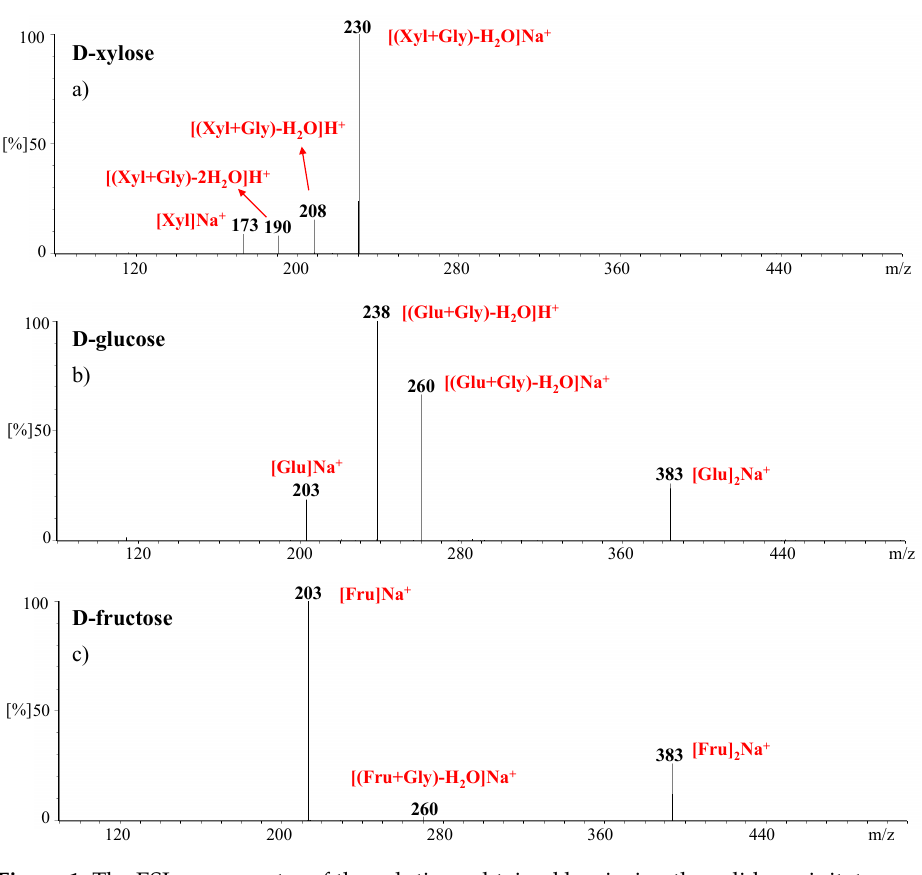
Figure 1. The ESI mass spectra of the solutions obtained by rinsing the solid precipitate generated by the ESI microdroplet deposition of: ( a ) 1 mL of 1:1 L-glycine/D-xylose 10 − 3 M H 2 O/CH 3 OH 3:1 solution; ( b ) 1 mL of 1:1 L-glycine/D-glucose 10 − 3 M H 2 O/CH 3 OH 3:1 solution; ( c ) 1 mL of 1:1 L-glycine/D-fructose 10 − 3 M H 2 O/CH 3 OH 3:1 solution.